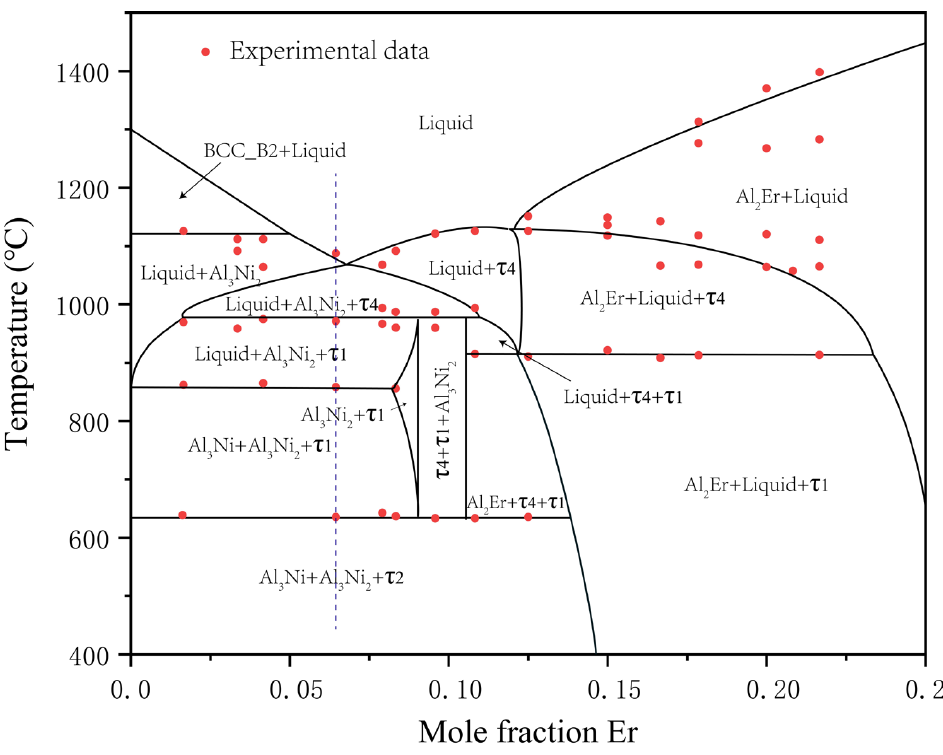
Figure 13. Calculated vertical section of the Al–Ni–Er phase diagram at Al 0.7 Ni 0.3 –Al 0.7 Er 0.3 with the experimental points of DSC thermal events.